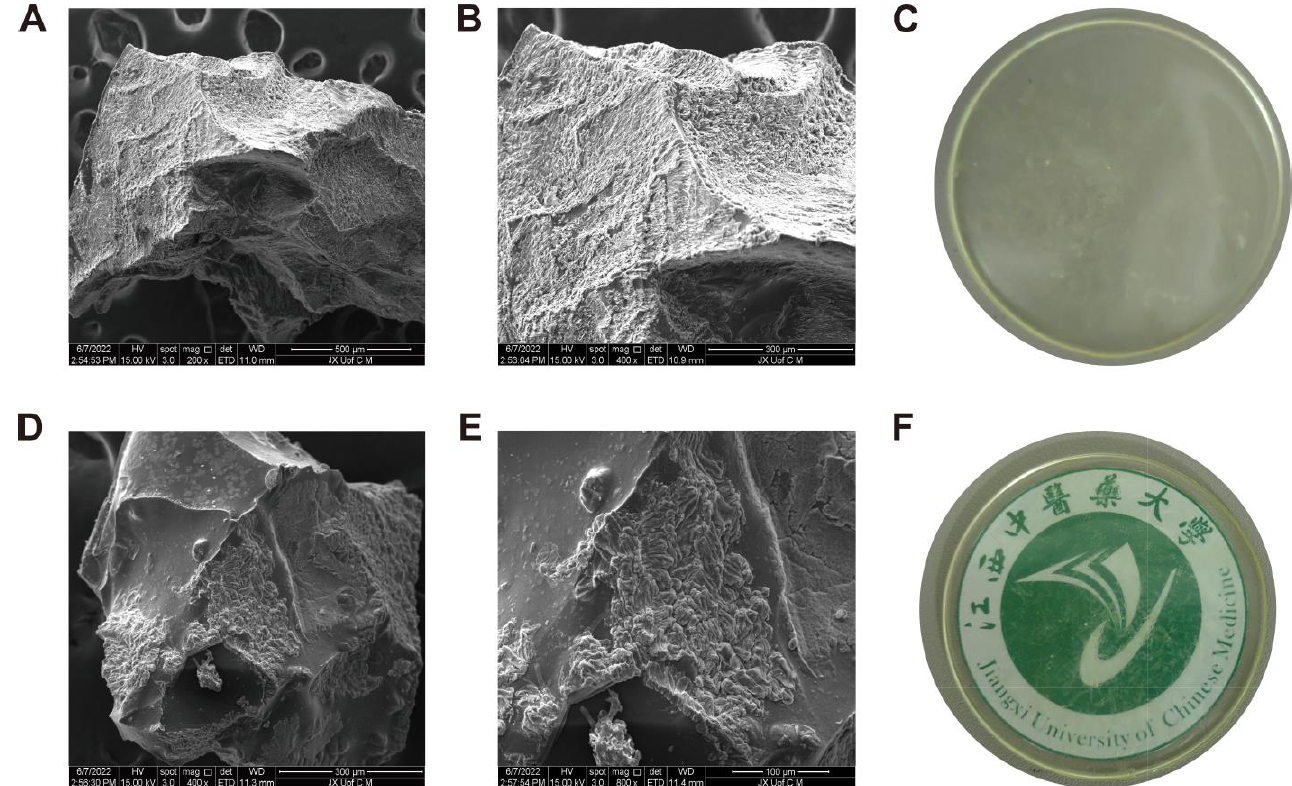
Figure 2. SEM images of hydrogel membranes at magnification of 200× ( A ), and 400× ( B ). Physical appearance of blank hydrogel membrane ( C ). SEM images of hydrogel membranes from different parts of the hydrogel at 400× ( D ), and 800× ( E ). Physical appearance of the hydrogel membrane with the university logo ( F ).